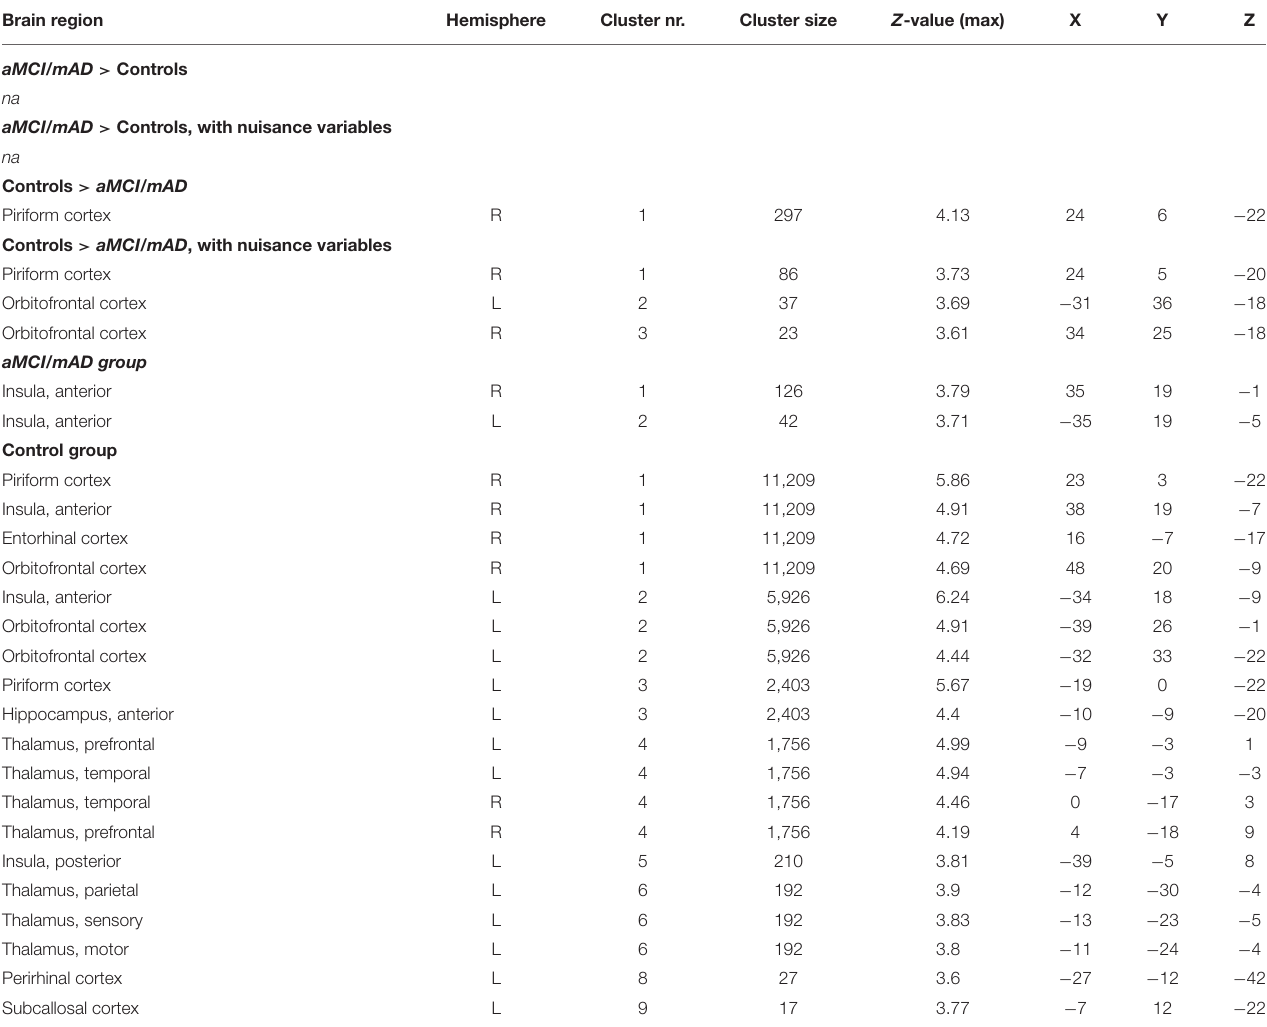
TABLE 4 | Location of peak brain activations in MNI space during odor identification in the control group and aMCI/mAD groups. Brain region Hemisphere Cluster